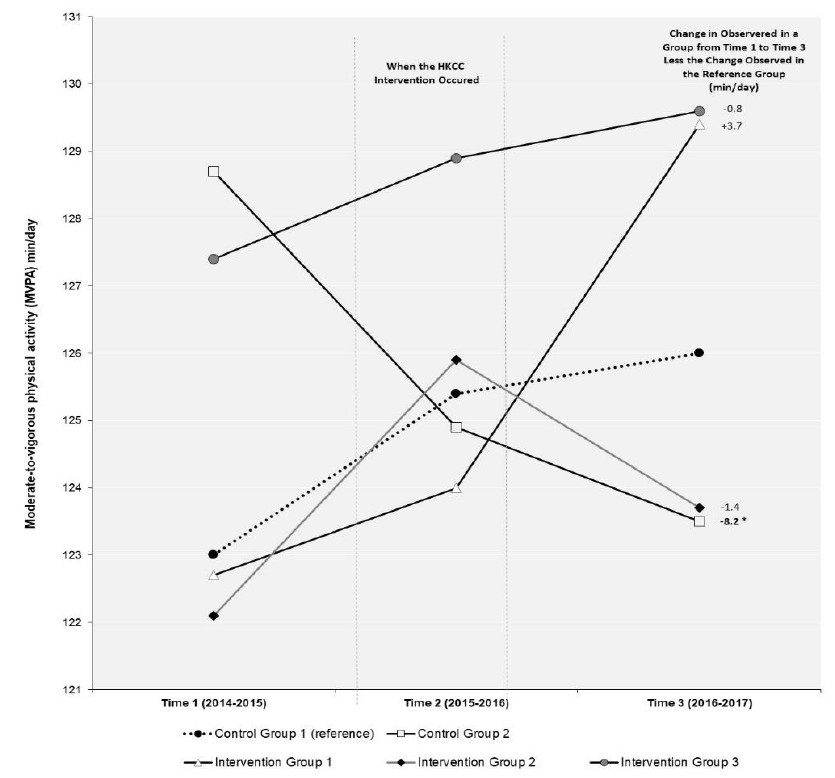
Figure 2. Difference-in-difference (DID) evaluation of the impact of the Healthy Kids Community